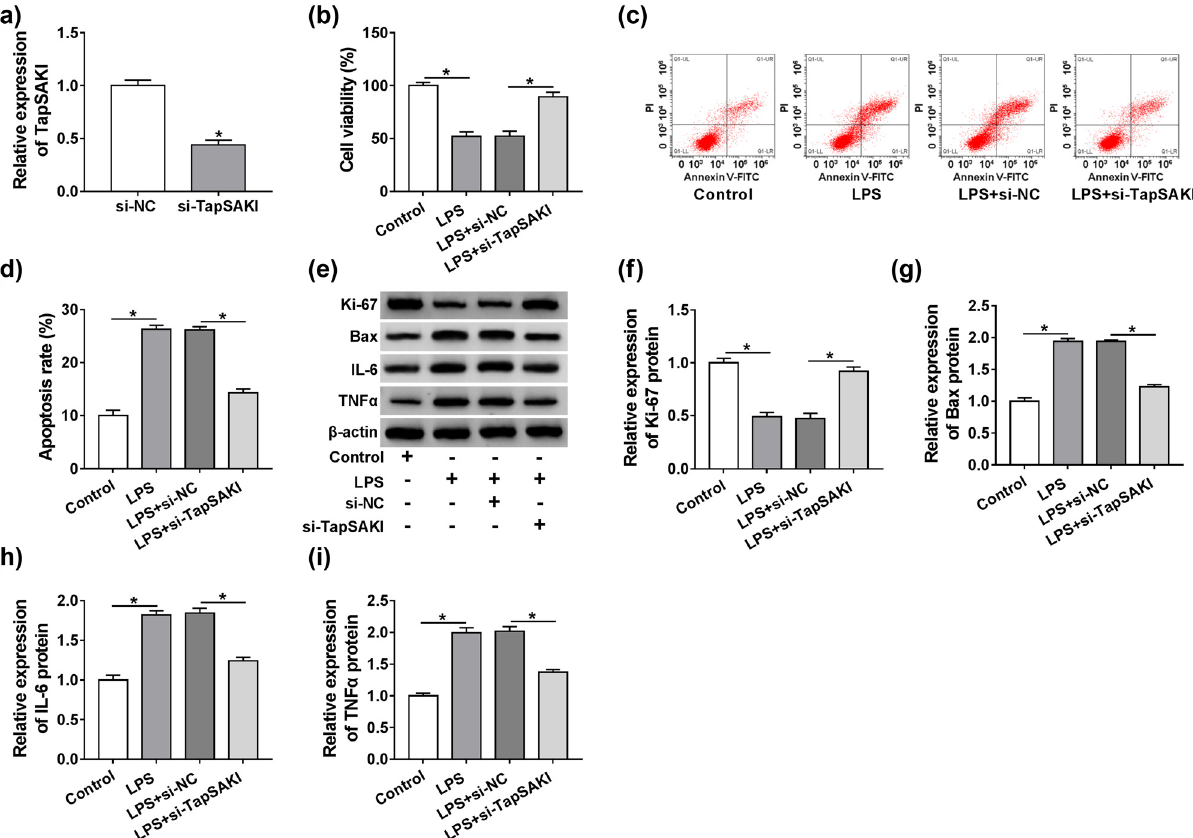
Figure 3: TapSAKI silencing attenuated LPS - induced damage in HK - 2 cells. ( a ) qRT - PCR for TapSAKI expression in HK - 2 cells transfected with si - NC or si - TapSAKI. Cell viability by CCK - 8 assay ( b ) , cell apoptosis by fl ow cytometry ( c and d ) , Ki - 67, Bax, IL - 6, and TNF α levels by western blot ( e – i ) in HK - 2 cells transfected with or without si - NC or si - TapSAKI before LPS exposure. * P <